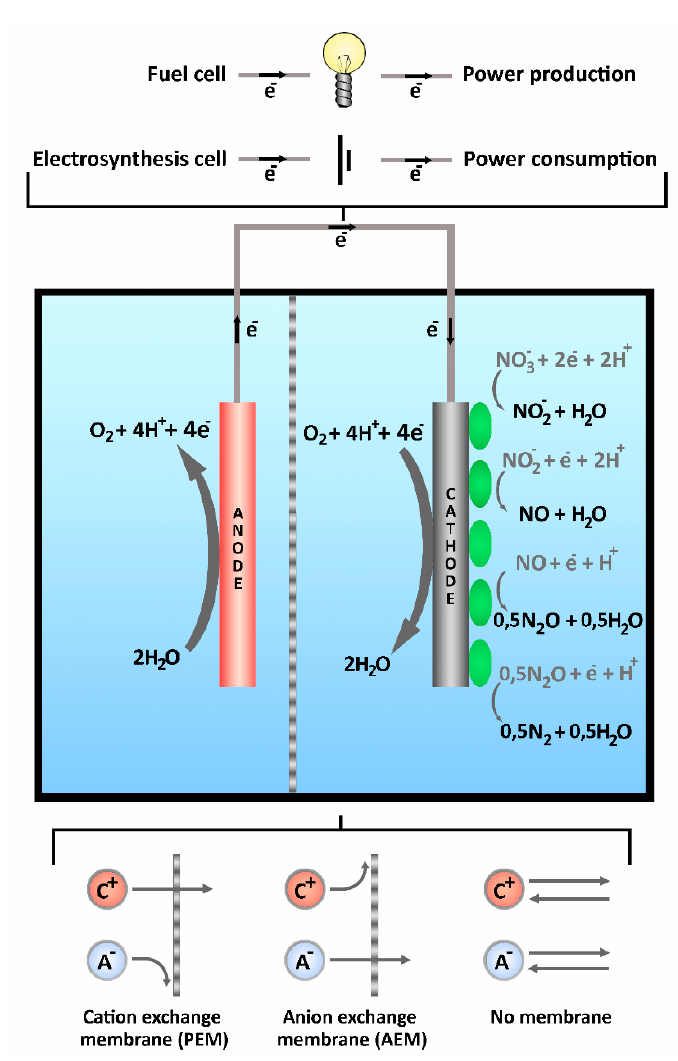
Figure A1. A basic setup of the bioelectrochemical system, where water is oxidized on the abiotic anode and NO 3 and oxygen are reduced by the biocathode via autotrophic denitrification. The electrodes can be separated by the membrane to process two di ff erent types of electrolyte, di ff erent type of membranes are shown at the bottom. Electron flow direction when it is operated as a electrosynthesis cell is shown on the wire and di ff erent external circuit options are shown on top. Four step autotrophic denitrification is shown on the biocathode [45].